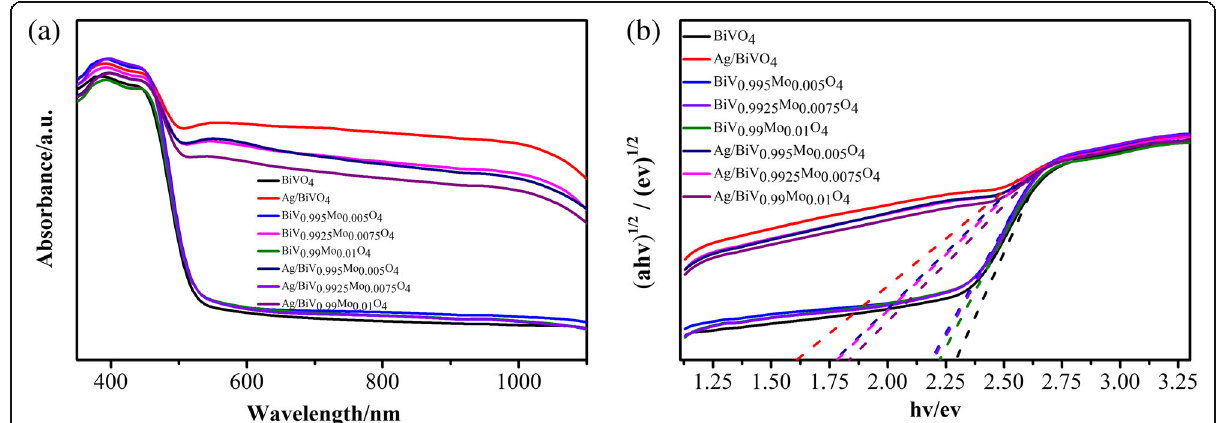
Fig. 6 The photophysical properties of the as-prepared materials. a UV – vis diffuse reflectance spectra of the BiVO 4 , Ag/BiVO 4 , BiV 1-x Mo x O 4 , and Ag /BiV 1-x Mo x O 4 . b Energy bandgap evaluation of the corresponding